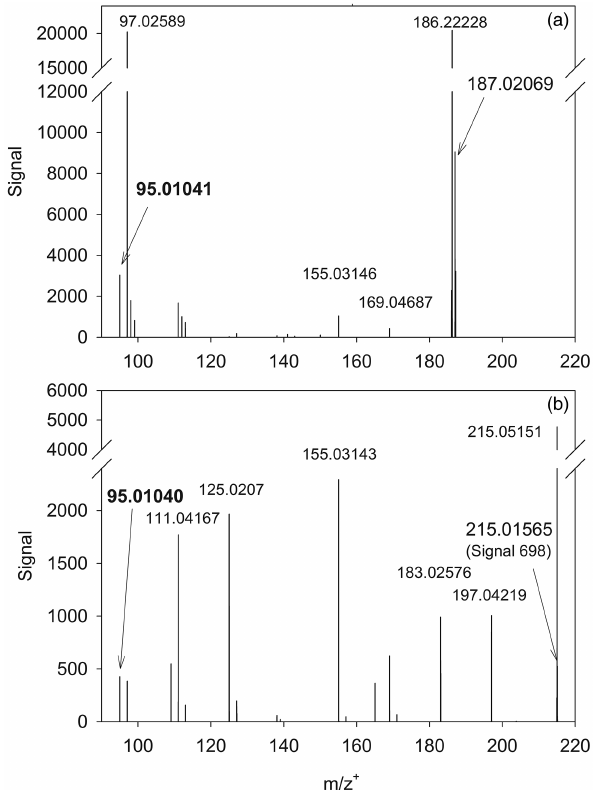
Figure 8. FTICR-MS/MS for m/z + 187 for PHA 1 (a) and m/z + 215 for PHA 2 (b) .